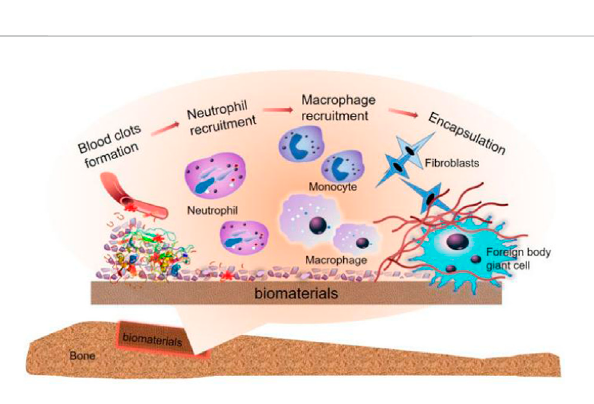
FIGURE 4 Immune cascade after bone implant material, the graph was reprinted with permission from (Xie et al.,